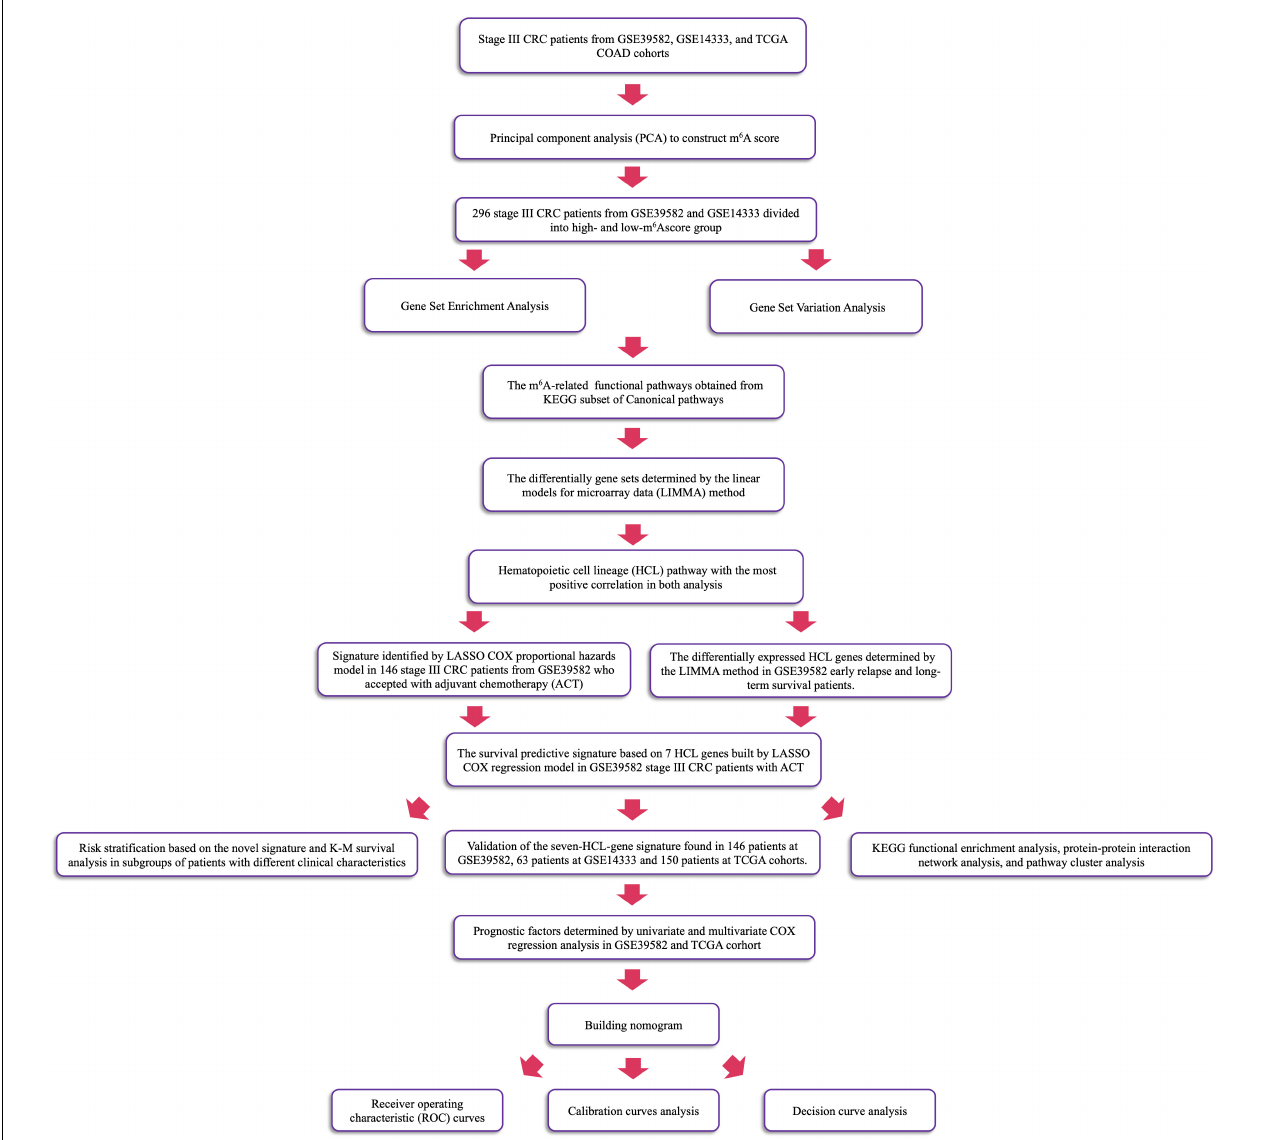
FIGURE 1 | The workflow of identification of CRC ACT-related seven-HCL signature.